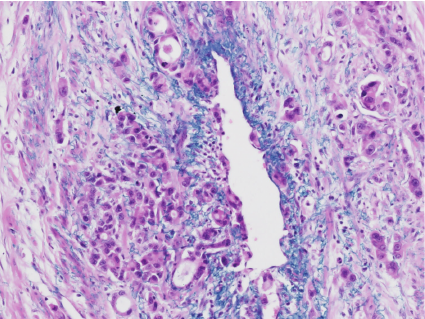
Figure 2: Victoria blue stain in metastatic ovarian tumor originat- ing from ascending colon cancer. Positive portions (blue) show ela- stic fibers of vessels. We found the cancer cells in the vessels. It means positivity for vascular